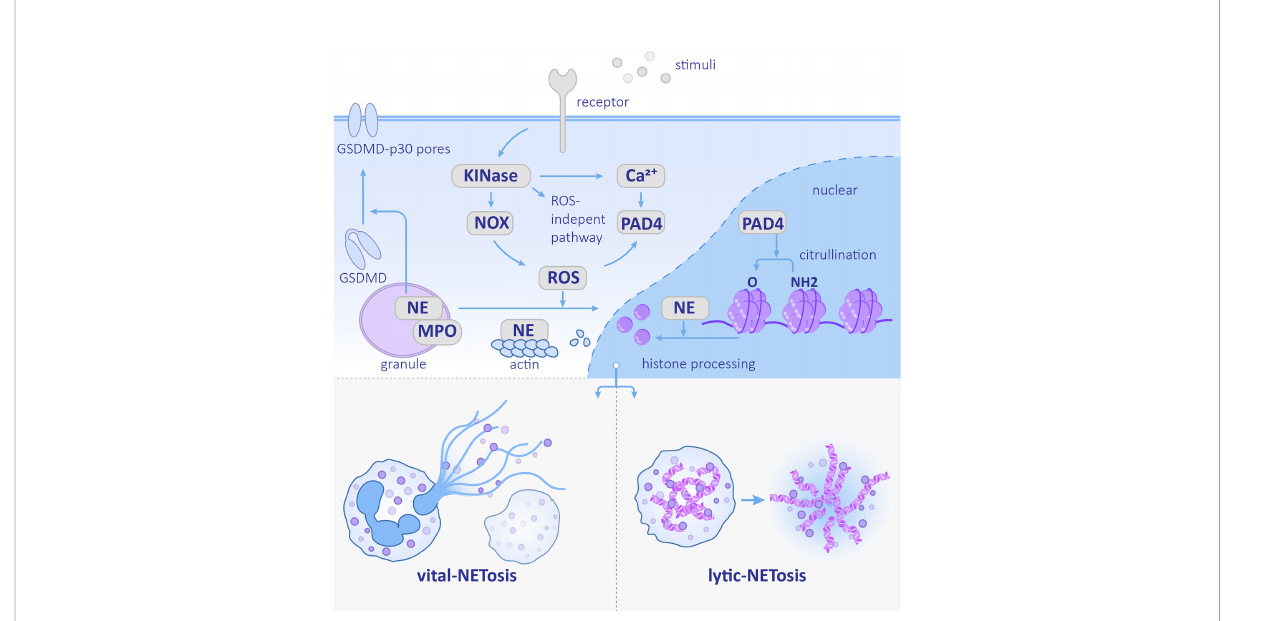
FIGURE 1 Neutrophil extracellular trap (NET) formation Stimulation recognized by the corresponding receptor activates the downstream kinase and ROS pathway or ROS-independent pathway. NE nuclear transfer is promoted by ROS and helps degrades histones. PAD4 promotes histone citrullination. The NETs formation can be divided into vital-NETosis and lytic-NETosis. NE, neutrophil elastase; PAD4, protein-arginine deiminase type 4; MPO, myeloperoxidase; NOX, NADPH oxidase; ROS, reactive oxygen